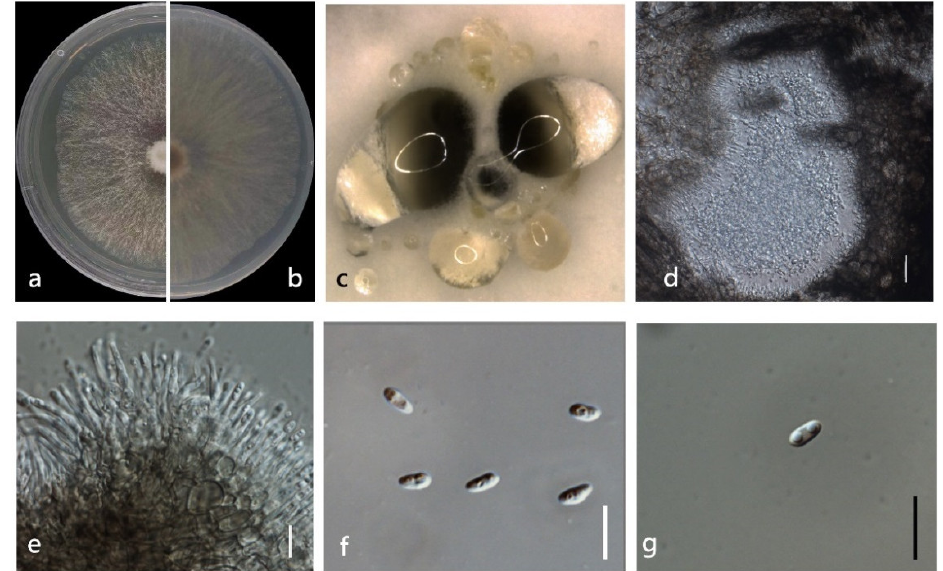
Figure 10. Diaporthe morindae (ZHKUCC 22-0072) ( a ) upper view of colonies on PDA; ( b ) Reverse view of colonies on PDA; ( c ) Conidiomata sporulating on PDA; ( d ) longitudinal section of